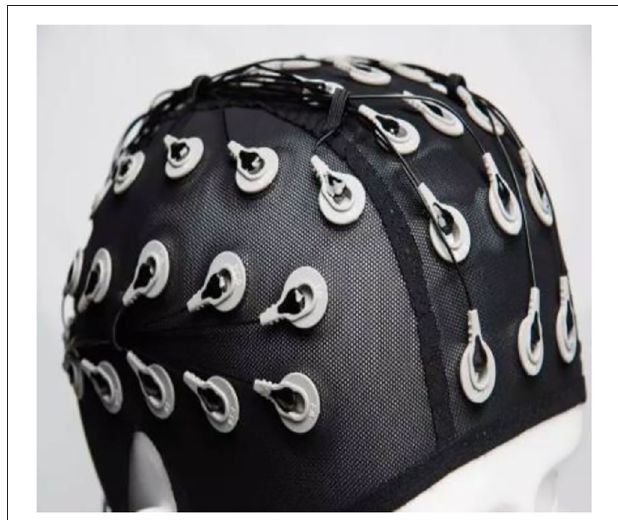
FIGURE 1 | The EEG headset used to collect the data.